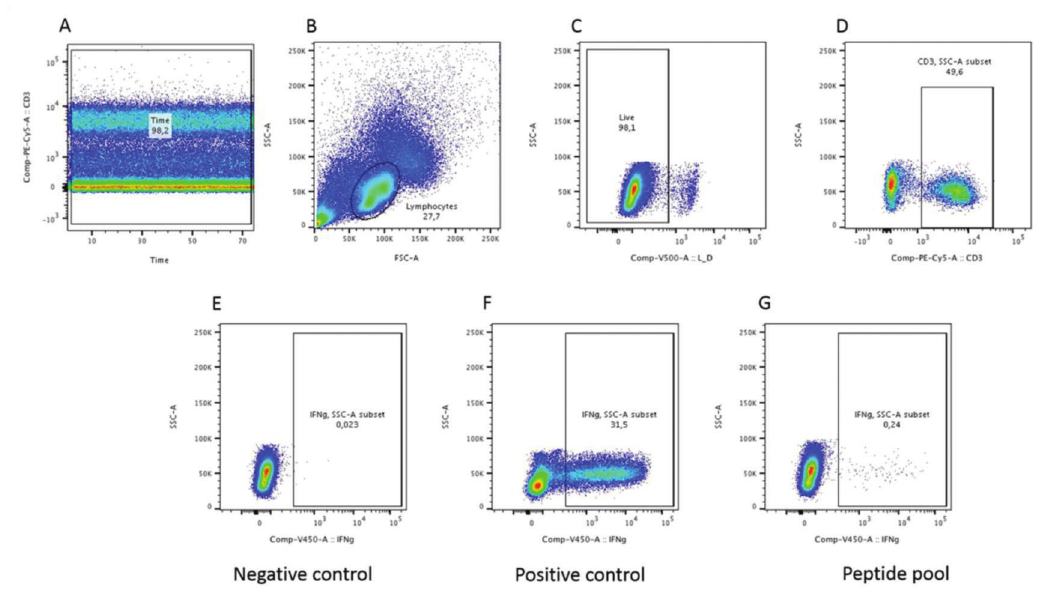
Figure S1 - Representative flow cytometry plots of IFN- g expression by CD3 + Tcells from one convalescent COVID-19 individual. (A) The PE-Cy5 x time analysis strategy was employed to exclude possible unstable cell flow, after which size and granularity patterns of cells were analyzed by FSC and SSC (B) and therefore within the live cell population (C). CD3 + Tcells were analyzed (D) for IFN- g production in the negative control (without stimulation) (E) or following stimulation with phorbol myristate acetate and ionomycin (positive control) (F) or SARS-CoV-2 peptide pools (G). Samples were acquired on an LSR Fortessa (BD). Flow cytometry data were analyzed using FlowJo v.10 software.